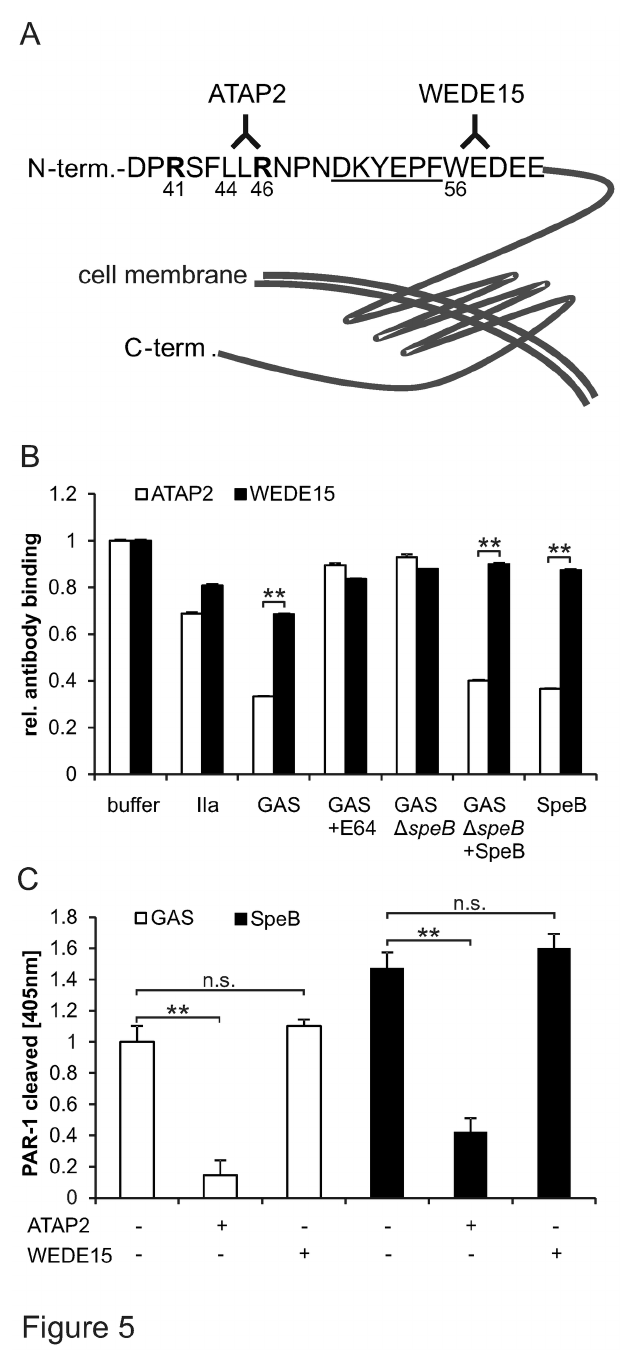
Figure 5. SpeB cleaved endogenous PAR-1 at the ATAP2 epitope and ATAP2 blocked cleavage of overexpressed PAR-1. ( A ) Scheme of PAR-1’s extracellular N-terminus. In bold are given the thrombin and activated protein C cleavage (and activation) sites shown at arginine and arginine , respectively. Underscores mark the hirudin binding site, the domain directly 41 46 binding thrombin’s exosite I. Further monoclonal anti-PAR-1 ATAP2 and WEDE15 epitopes are provided. ( B ) Following incubation of endothelial EA.hy926 cells with given agonists, supernatants from GAS or SpeB deficient GAS in the absence or together with protease inhibitor E64 or SpeB cells were fixed with PFA and epitopes of anti-PAR-1 ATAP2 (white bars) and WEDE15 (black bars) were quantified by cell surface ELISA. ( C ) Following incubation with either anti-PAR-1 ATAP2 or WEDE15, 293T cells transiently over-expressing AP-PAR-1 were assessed for PAR-1 cleavage by GAS supernatant and commercial SpeB. Experiments were repeated at least 3 times with N=9 per point, data presented as mean+/- SEM, ** P <0.01. doi: 10.1371/journal.pone.0081298.g005 PLOS ONE |